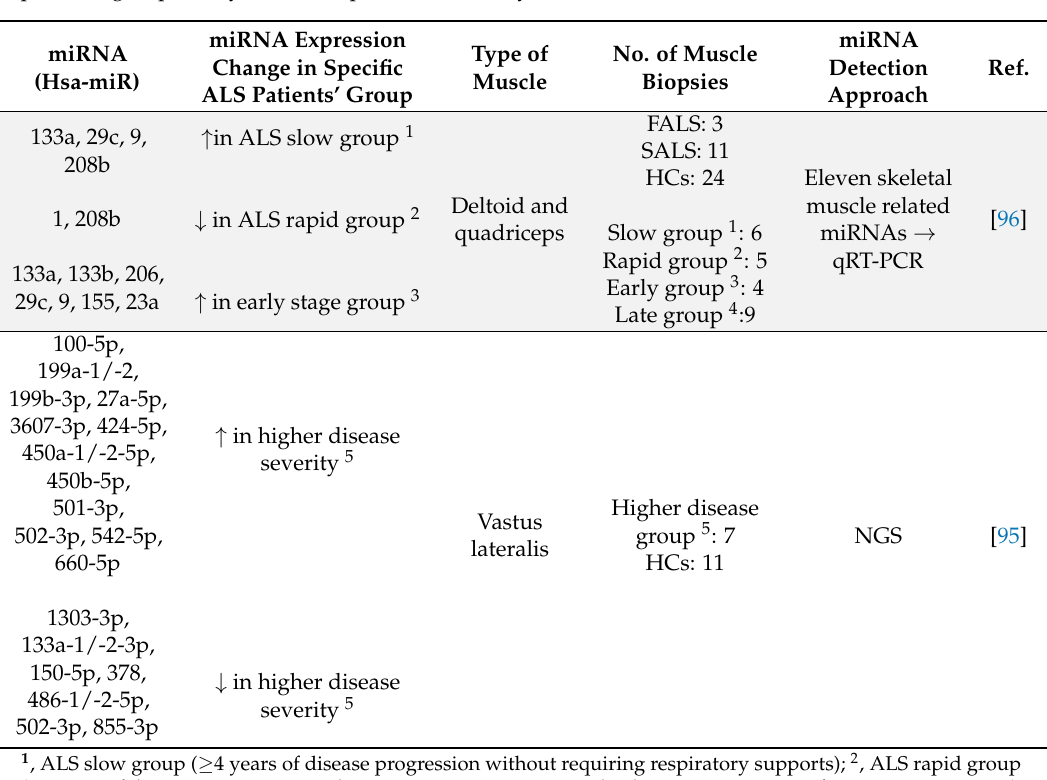
Table 5. Deregulated miRNAs in skeletal muscle biopsies of specific amyotrophic lateral sclerosis (ALS) patients’ groups analyzed in comparison to healthy